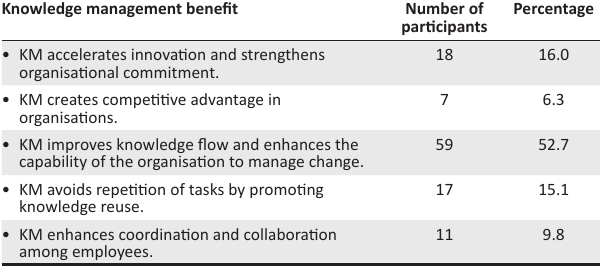
TABLE 1: Benefits of knowledge management in knowledge-intensive